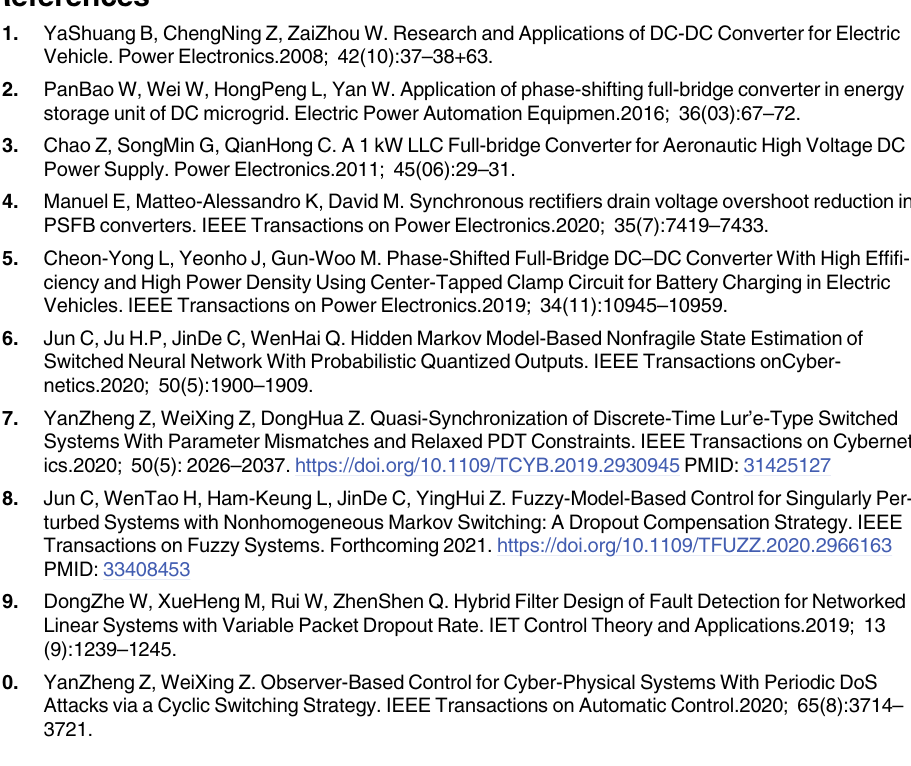
. Here is the specific framework of u eq